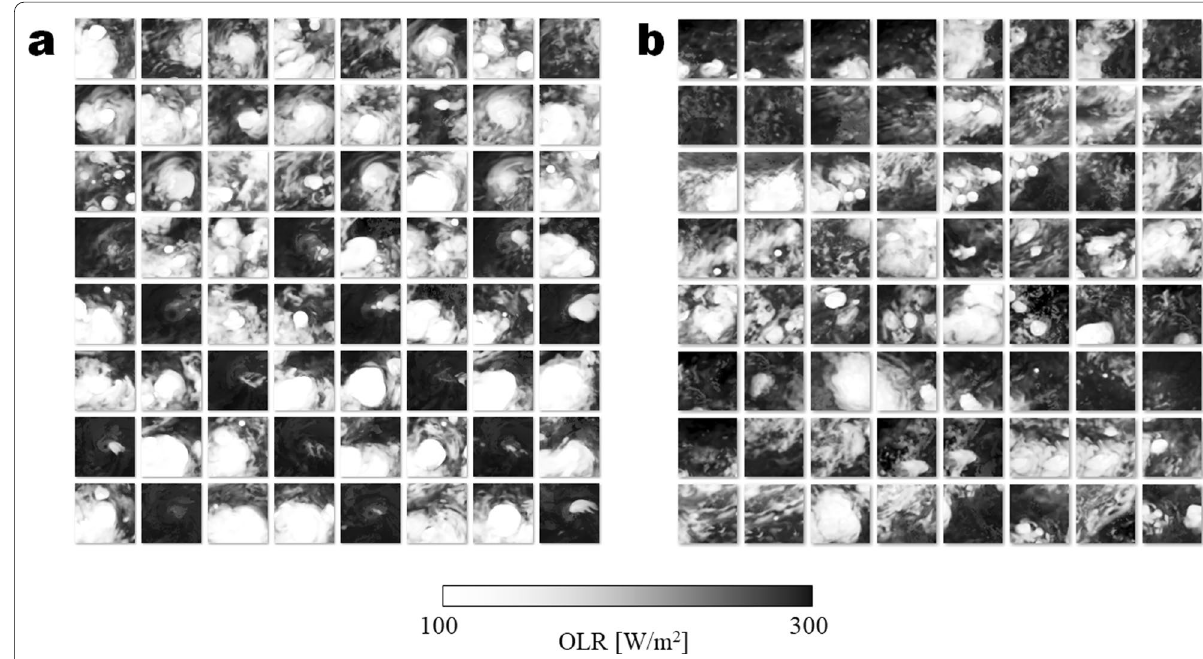
Fig. 1 Examples of training data. a TCs and b nonTCs (positive and negative examples,